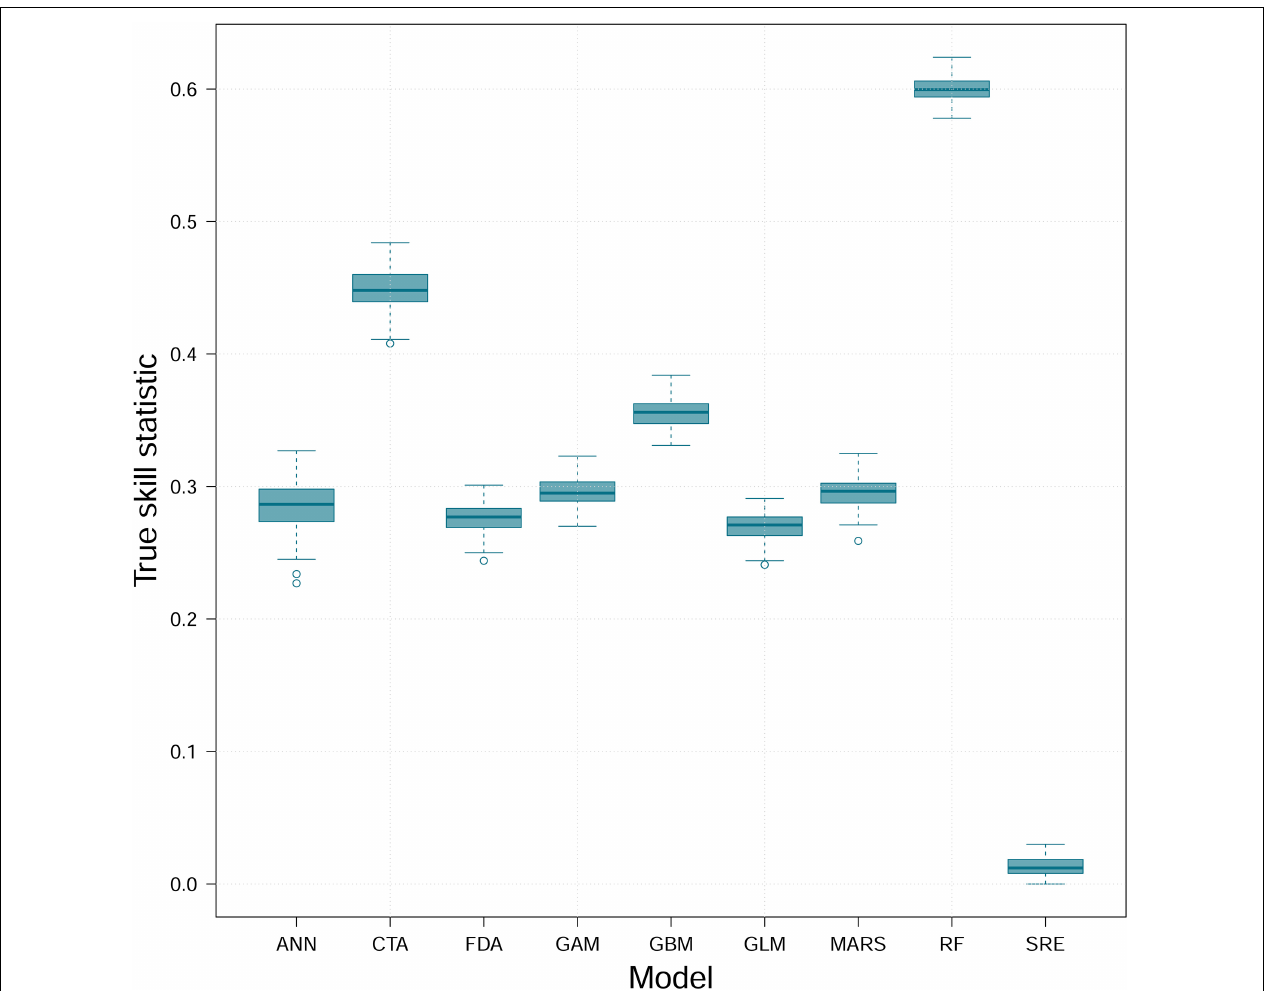
FIGURE 2 | Boxplot of the true skill statistic values from 9 single-models run 100 times each. ANN, Artificial Neural Network; CTA, Classification Tree Analysis; FDA, Flexible Discriminant Analysis; GAM, Generalized Additive Model; GBM, Generalized Boosting Model; GLM, Generalized Linear Model; MARS, Multiple Adaptive Regression Splines; RF, Random forest; SRE, Surface Range